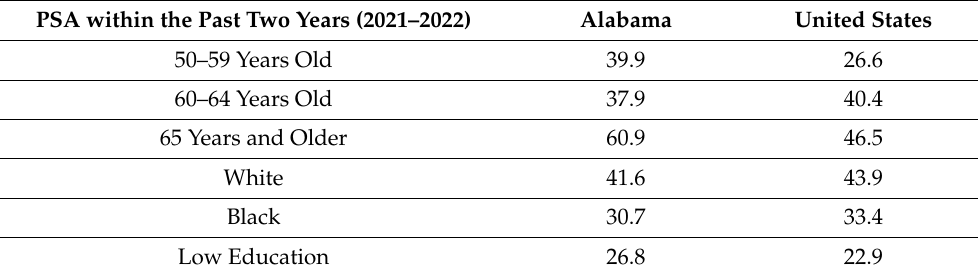
Table 4. Percentage of Prostate Cancer Screening, Men 50 and Older, Alabama and the U.S., 2018. Source: Behavioral Risk Factor Surveillance System, Centers for Disease Control and Prevention (2021)